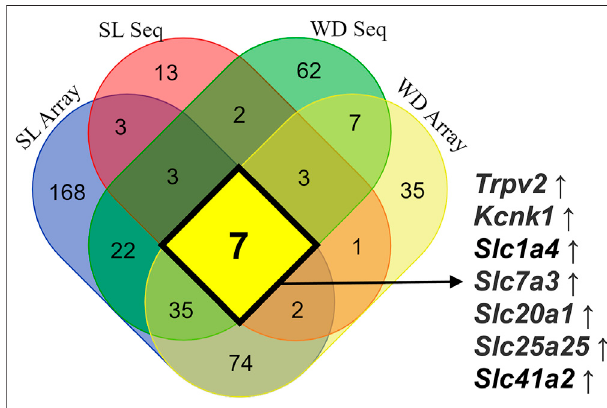
FIGURE 2 | Integrated data on the expression of mRNA coding ion channels and membrane transporters in the SON in response to long-term exposure to hyperosmolality in rats. Microarray data obtained from water- deprived (WD) rats are from Hindmarch et al. (2006), microarray information from WD and salt loading (SL) rats is from Greenwood M. P. et al. (2015), RNAseq data obtained from SL rats are from Johnson et al. (2015), and fi nally data on RNAseq obtained from WD rats are from Pau ž a et al. (2021). This integrated analysis revealed seven core genes coding channels and transporters consistently upregulated by sustained hyperosmotic stimulation: Trpv2, Kcnk1, Slc1a4, Slc7a3, Slc20a1, Slc25a25, and Slc41a2